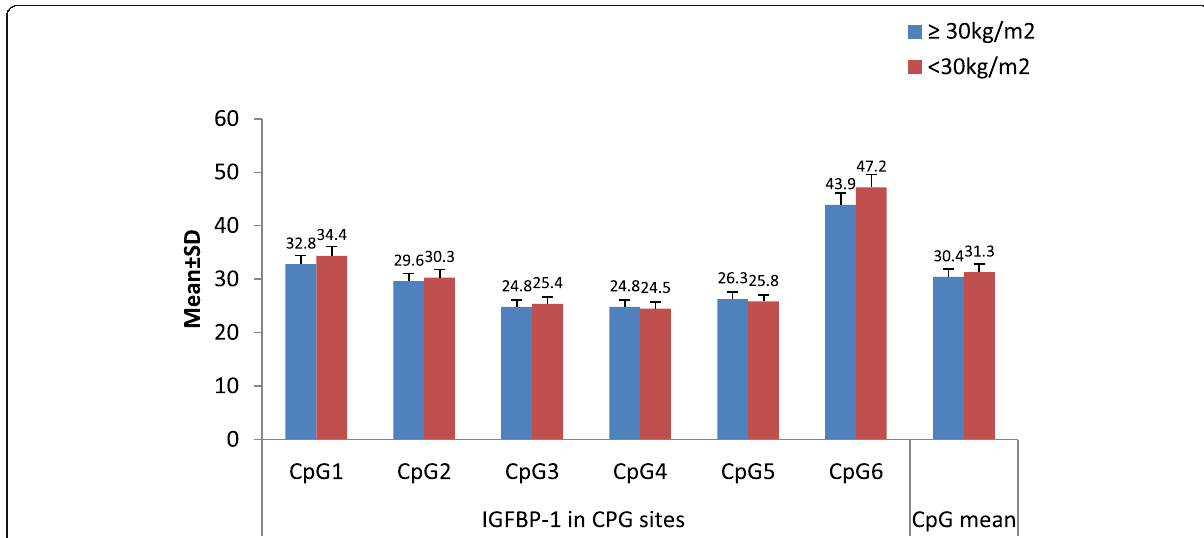
Fig. 2 Comparison of IGFBP1 DNA methylation levels in six CPG sites in T2D patients with a BMI ≥ 30 kg/m 2 and a BMI < 30 kg/m 2 . T2D, type 2 diabetes; BMI, body mass